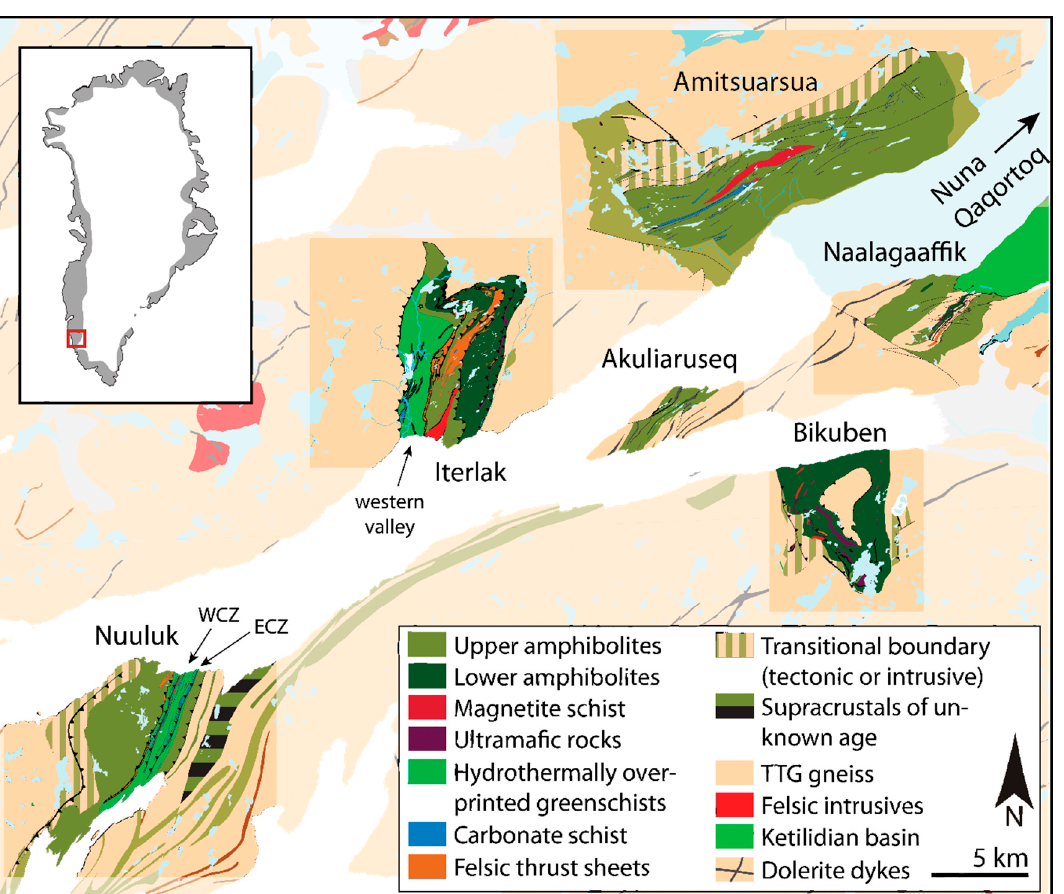
Figure 1. Simplified geological map for the Tartoq Greenstone Belt in SW Greenland showing the locations and geology of the different segments, and of the Western and Eastern Carbonate Zones. Nuna Qaqortoq is located in the inland ice approximately 20 km to the NE of Amitsuarsua. Modified after [2].